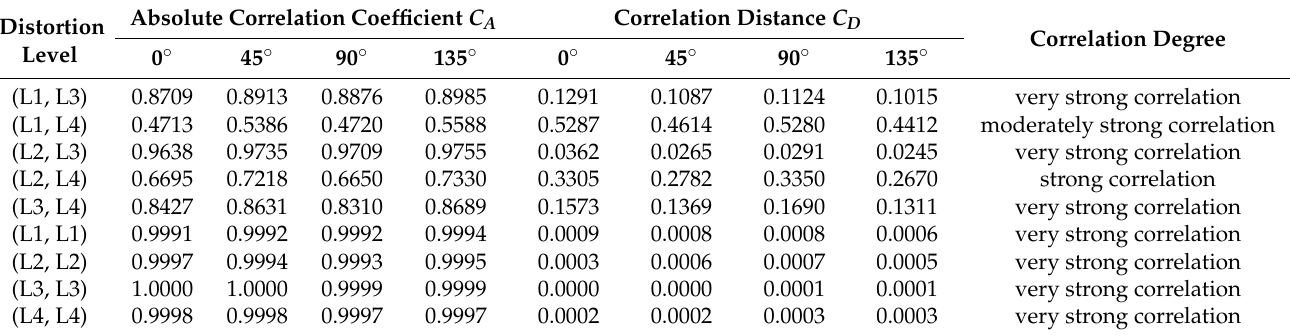
Table 1. C A and C D of distorted viewport’ left and right views processed by DurandTMO under encoding with 9 distortion levels.